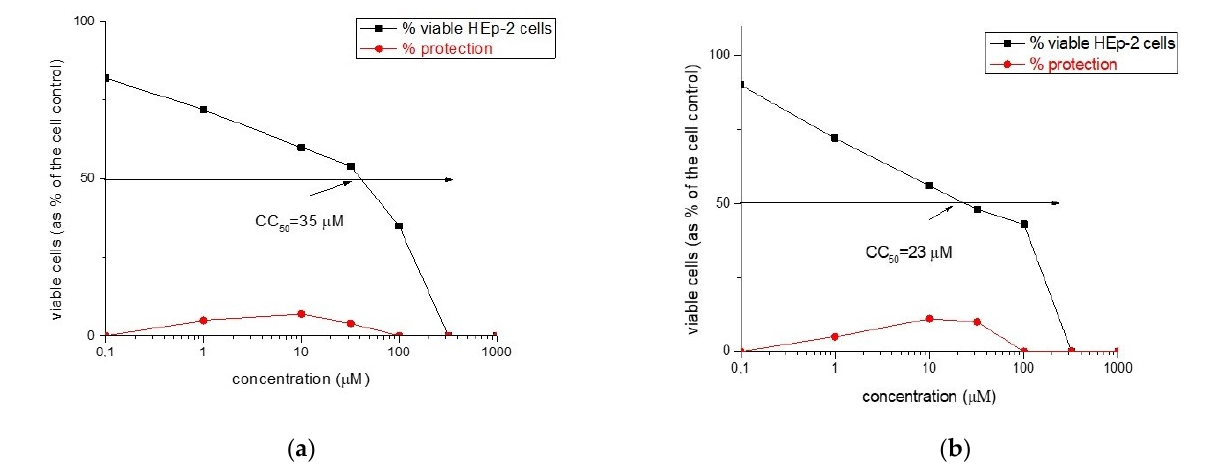
Figure 12. Antiviral activity curve (in red) and cytotoxicity curve (in black) of: ( a ) Rh-1 and ( b ) Rh-2.